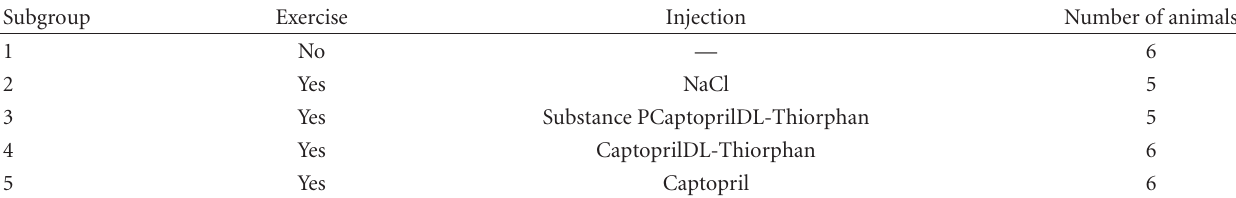
Table 1: Summary of the five subgroups of animals analyzed. The number of animals for which soleus specimens were analysed is shown. Subgroups 3–5 had been given pro-inflammatory substances/endopeptidase inhibitors in combination with exercise. The subgroups 1 and 2 are collectively referred to as comprising the “nonmyositis group” and those of subgroups 3–5 as comprising the “myositis group” in the